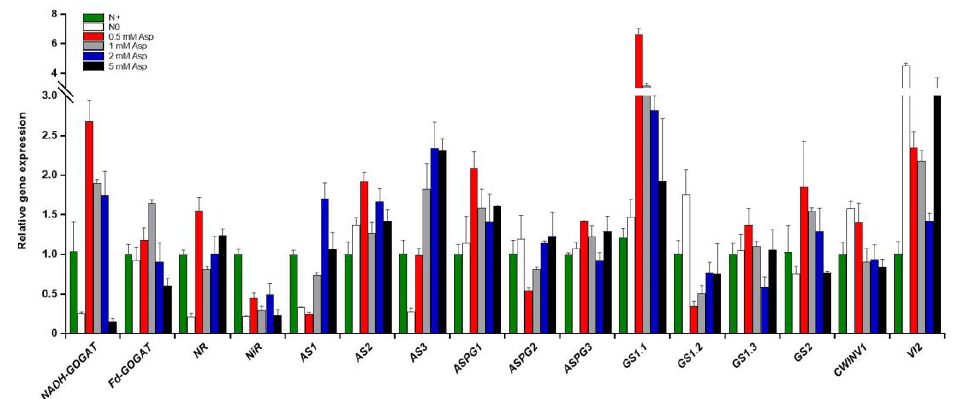
Figure 6. Transcriptional changes of genes related to the N and C metabolism pathways in poplar ‘Nanlin895’ roots in response to asparagine (Asn) treatment. NR , nitrate reductase; GS , glutamine synthase; NADH-GOGAT , nicotinamide adenine dinucleotide-dependent glutamate synthase; Fd-